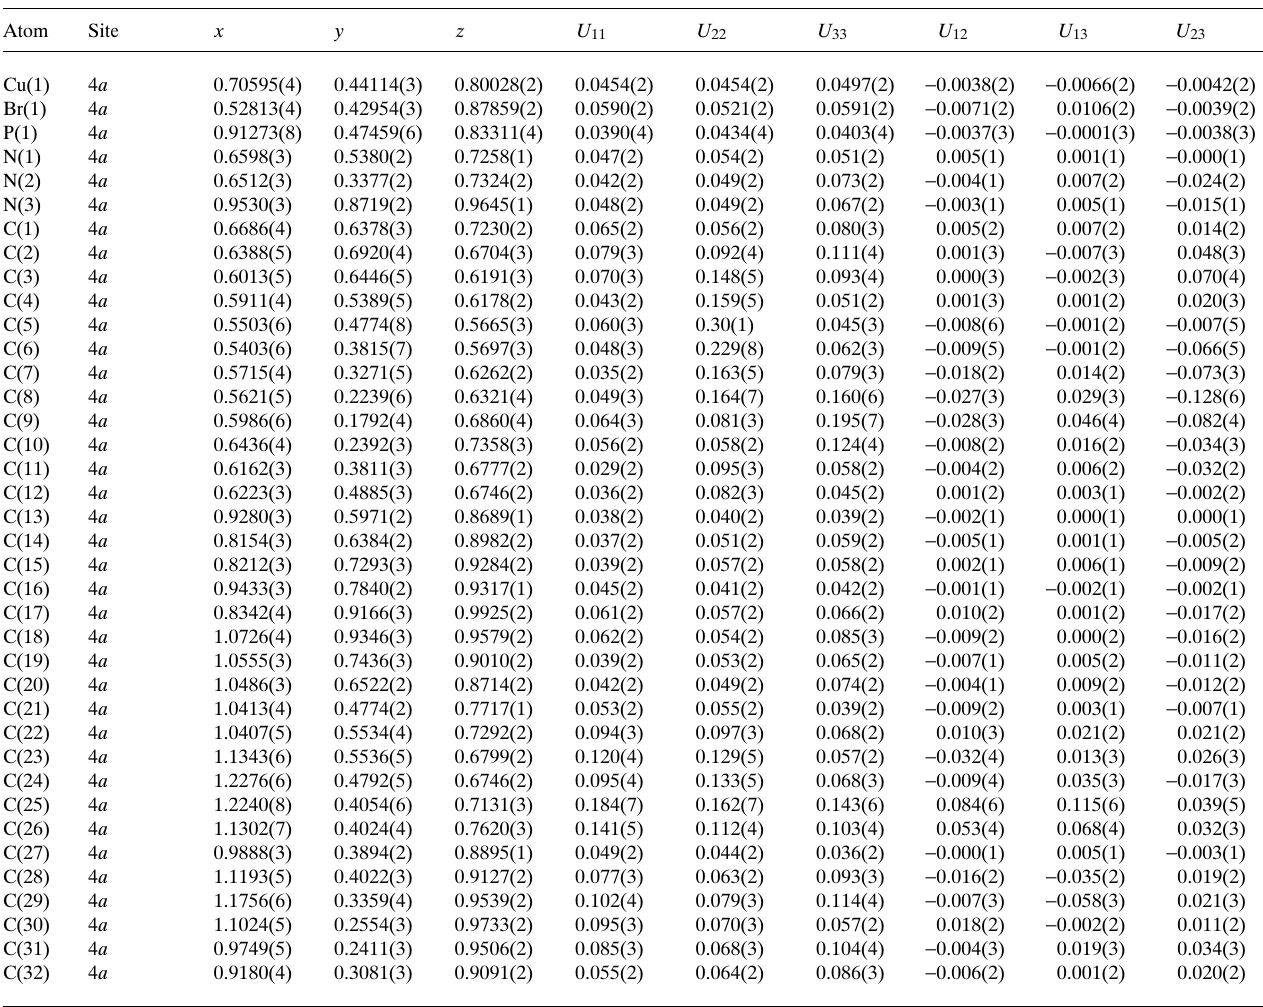
Table 3. Atomic coordinates and displacement parameters (in Å 2 )